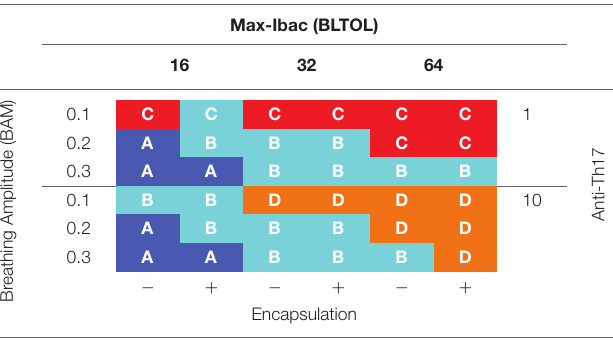
TABLE 3 | Phenotypical characteristics of the lesions according to the four main factors previously identified as being able to favor the infiltration of Mtb -infected lesions with